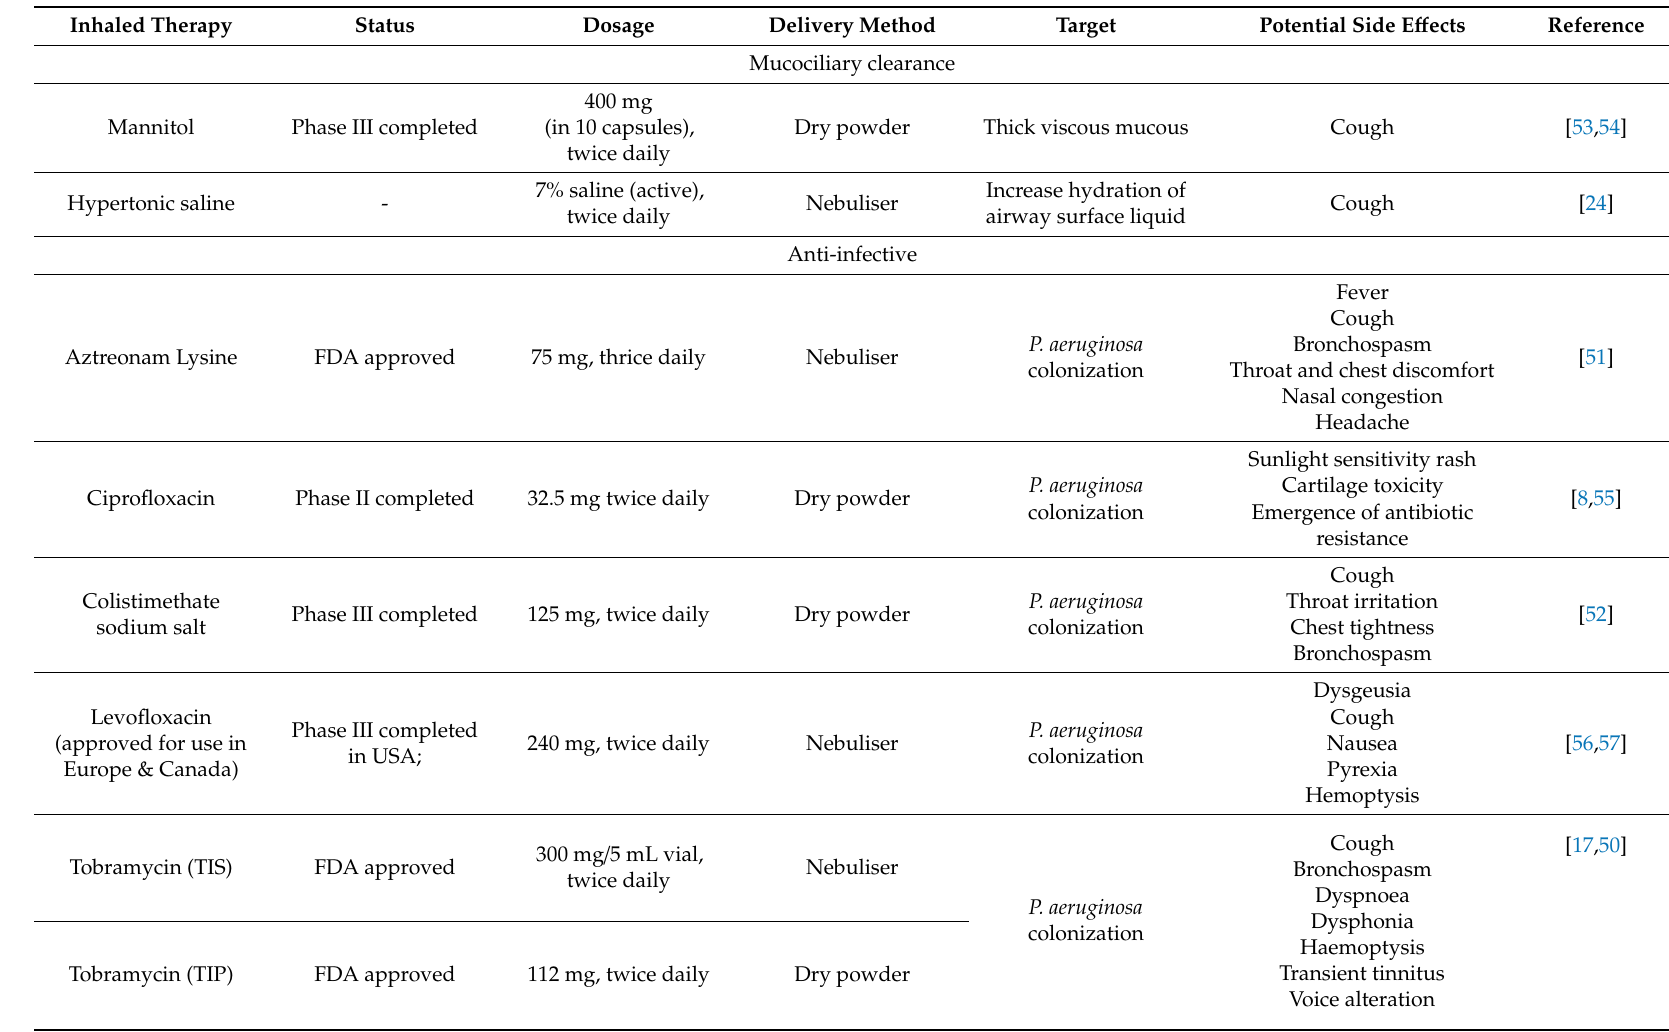
Table 4. Inhaled therapies currently used for treatment of